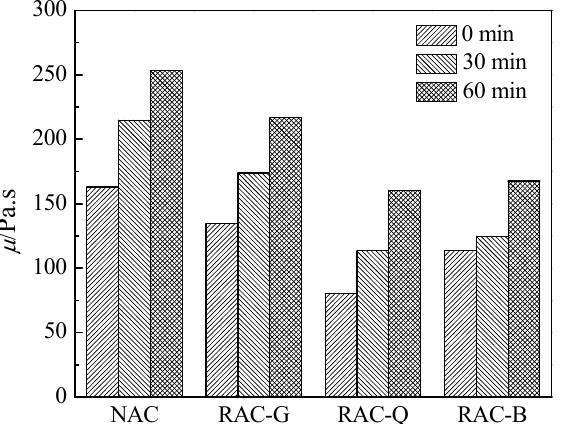
Figure 4. The effect of different coarse aggregates on the plastic viscosity of concrete.